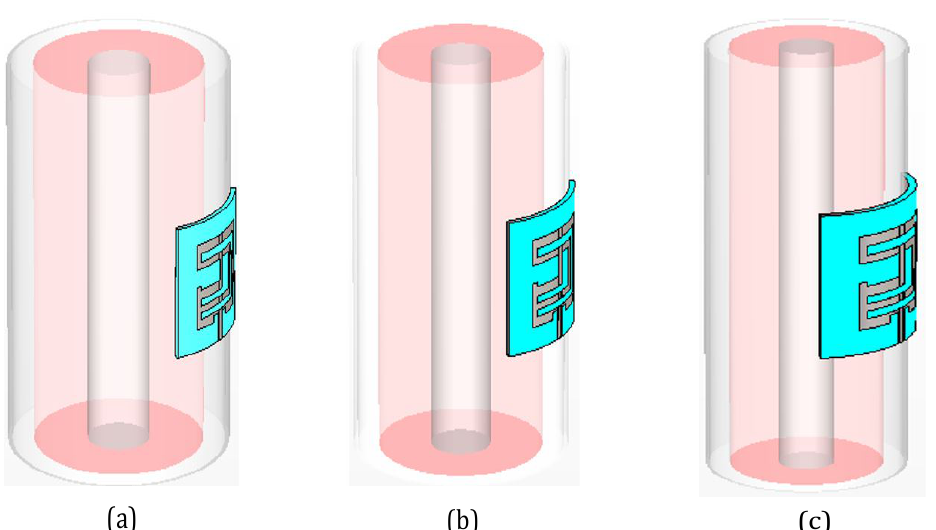
Figure 8. Antenna wrapped around four-layered body parts. ( a ) Leg of radius 70 mm; ( b ) arm of radius 60 mm; ( c ) arm of radius 40